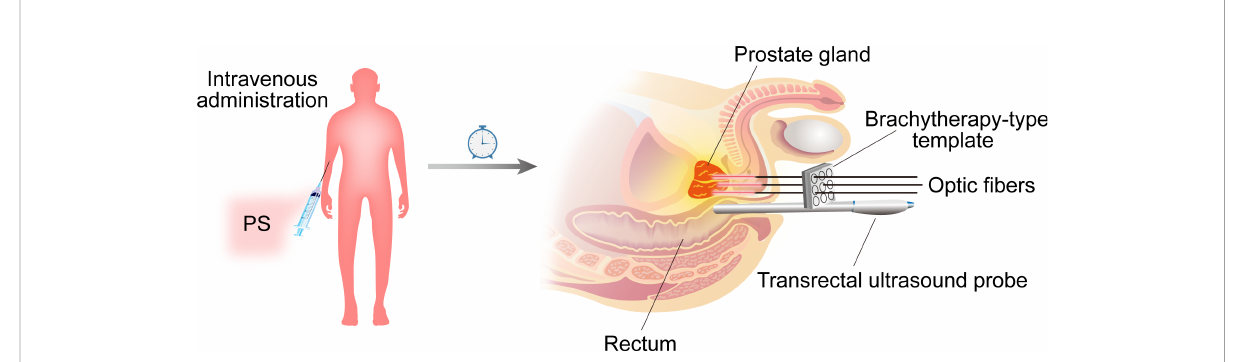
FIGURE 2 Mechanisms of PDT on tumors. Upon light activation, the 1 PS is converted from a ground state (S 0 ) to the excited singlet state (S 1 ) as 1 PS (cid:129) . 1 PS (cid:129) is excited to the triplet state (T 1 ) as 3 PS (cid:129) via intersystem crossing. Further, 3 PS (cid:129) promotes the generation of ROS through two mechanisms: type I reactions involve the formation of ROS, such as peroxides (H 2 O 2 , ROOH), superoxide anion(O 2- (cid:129) ), hydroxyl radical (HO (cid:129) ) and hydroxyl radicals (HOO (cid:129) ). Type II, the energy from 3 PS (cid:129) is directly transferred to triplet state oxygen ( 3 O 2 ) to form singlet oxygen ( 1 O 2 ). Ultimately leading to cellular toxicity, recruitment and activation of immune cells and vascular